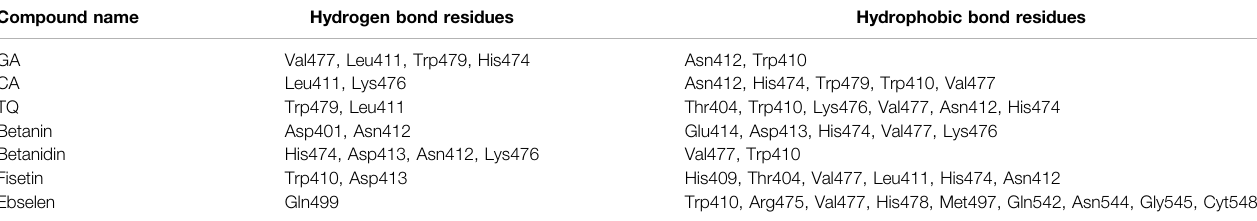
TABLE 2 | Amino acid residues contributed in molecular docking including hydrogen bond and hydrophobic bond.